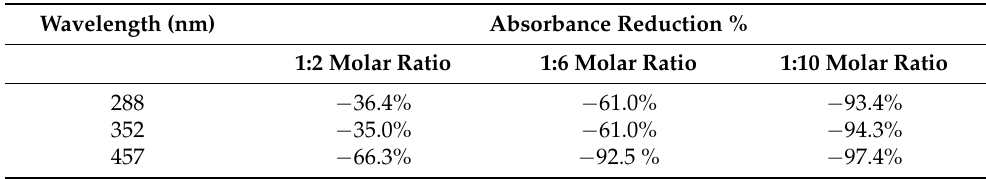
Table 1. Reduction (%) of the absorbance of the iodine bands in water solution at different iodine:CX molar ratio.